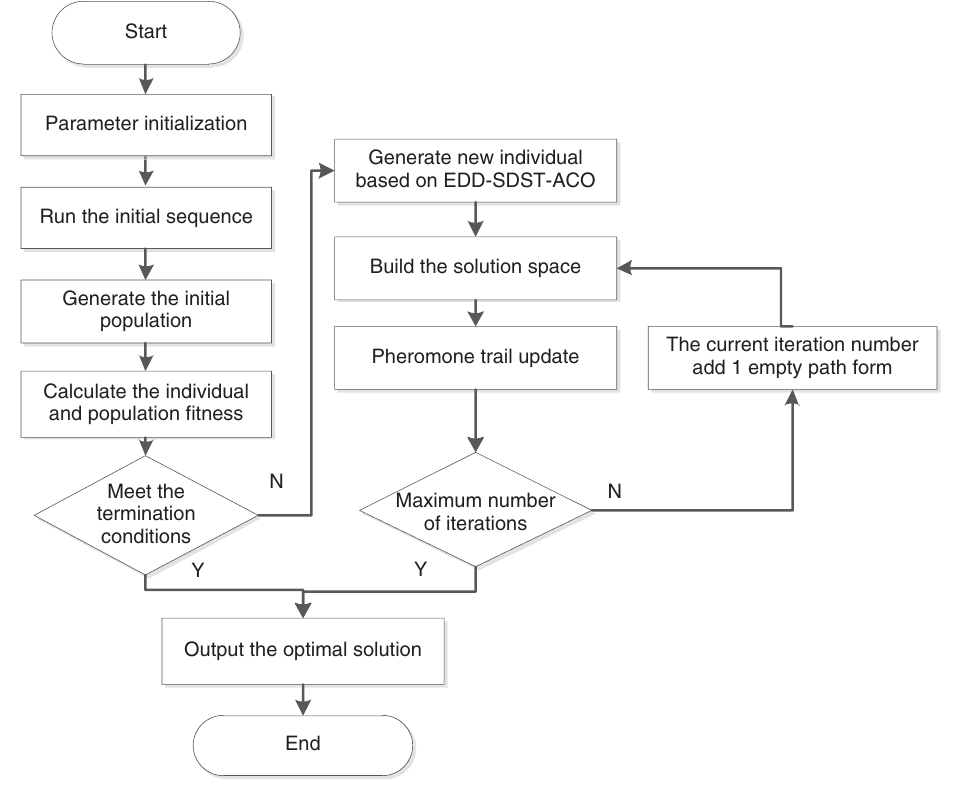
Figure 3: The Working Diagram of EDD-SDST-ACO Optimisation.